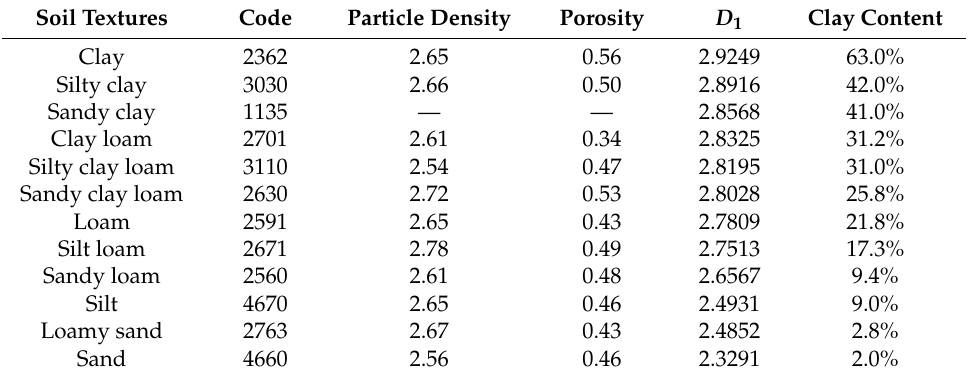
Table 5. Basic physical parameters of representative soil